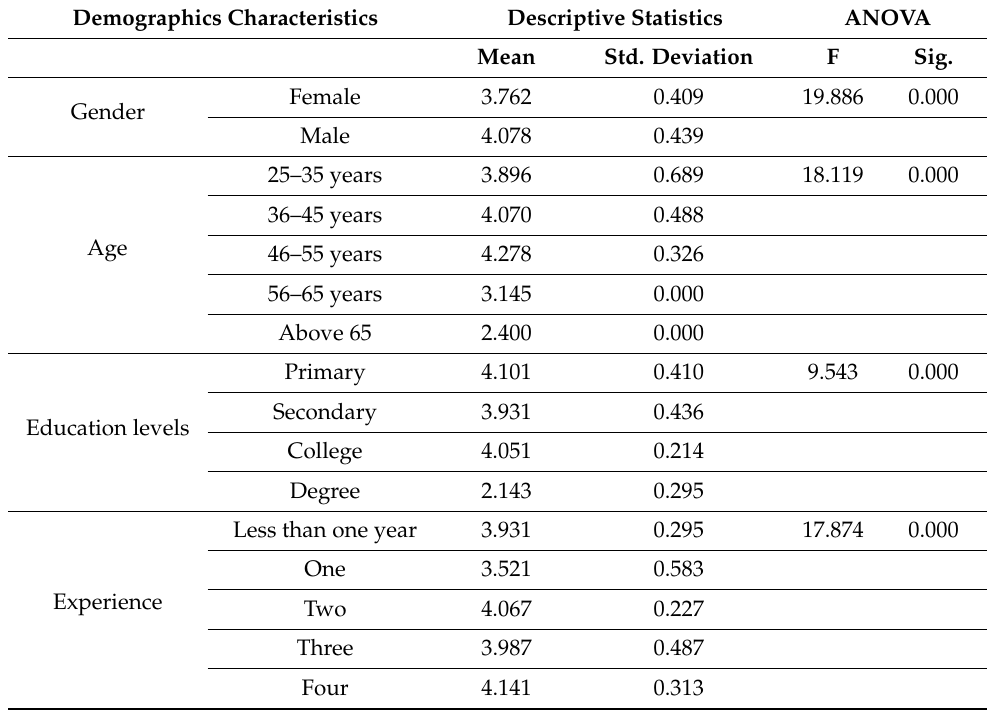
Table 8. Demographics of food handlers in Kenyan high school kitchens in relation to practice. Demographics Characteristics Descriptive